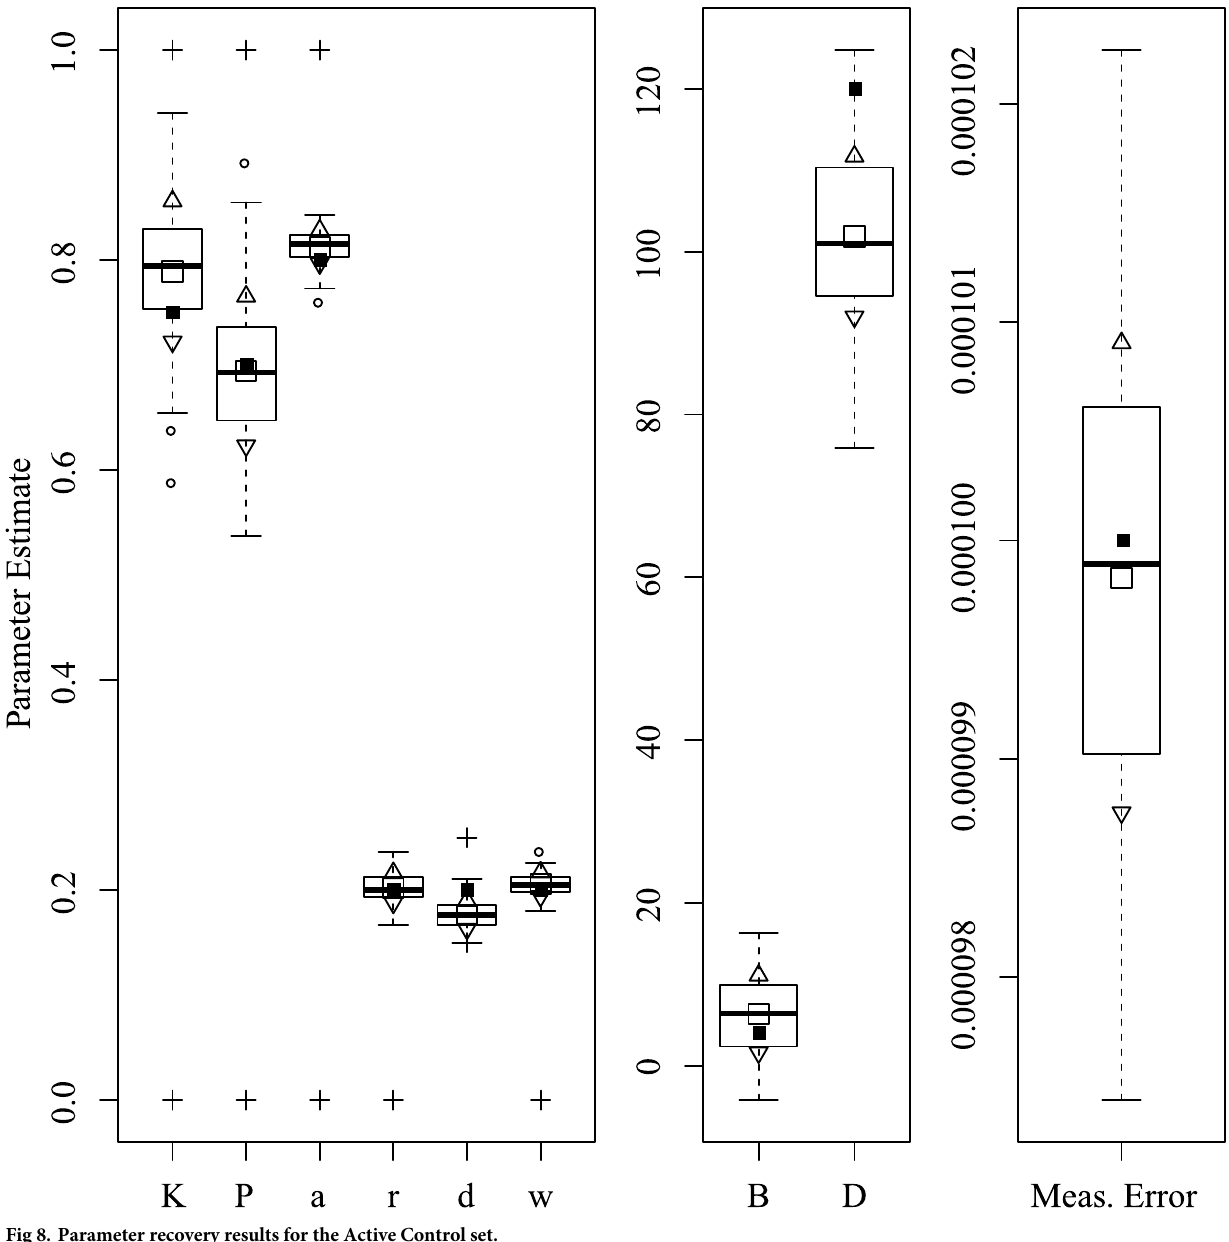
Fig 8. Parameter recovery results for the Active Control